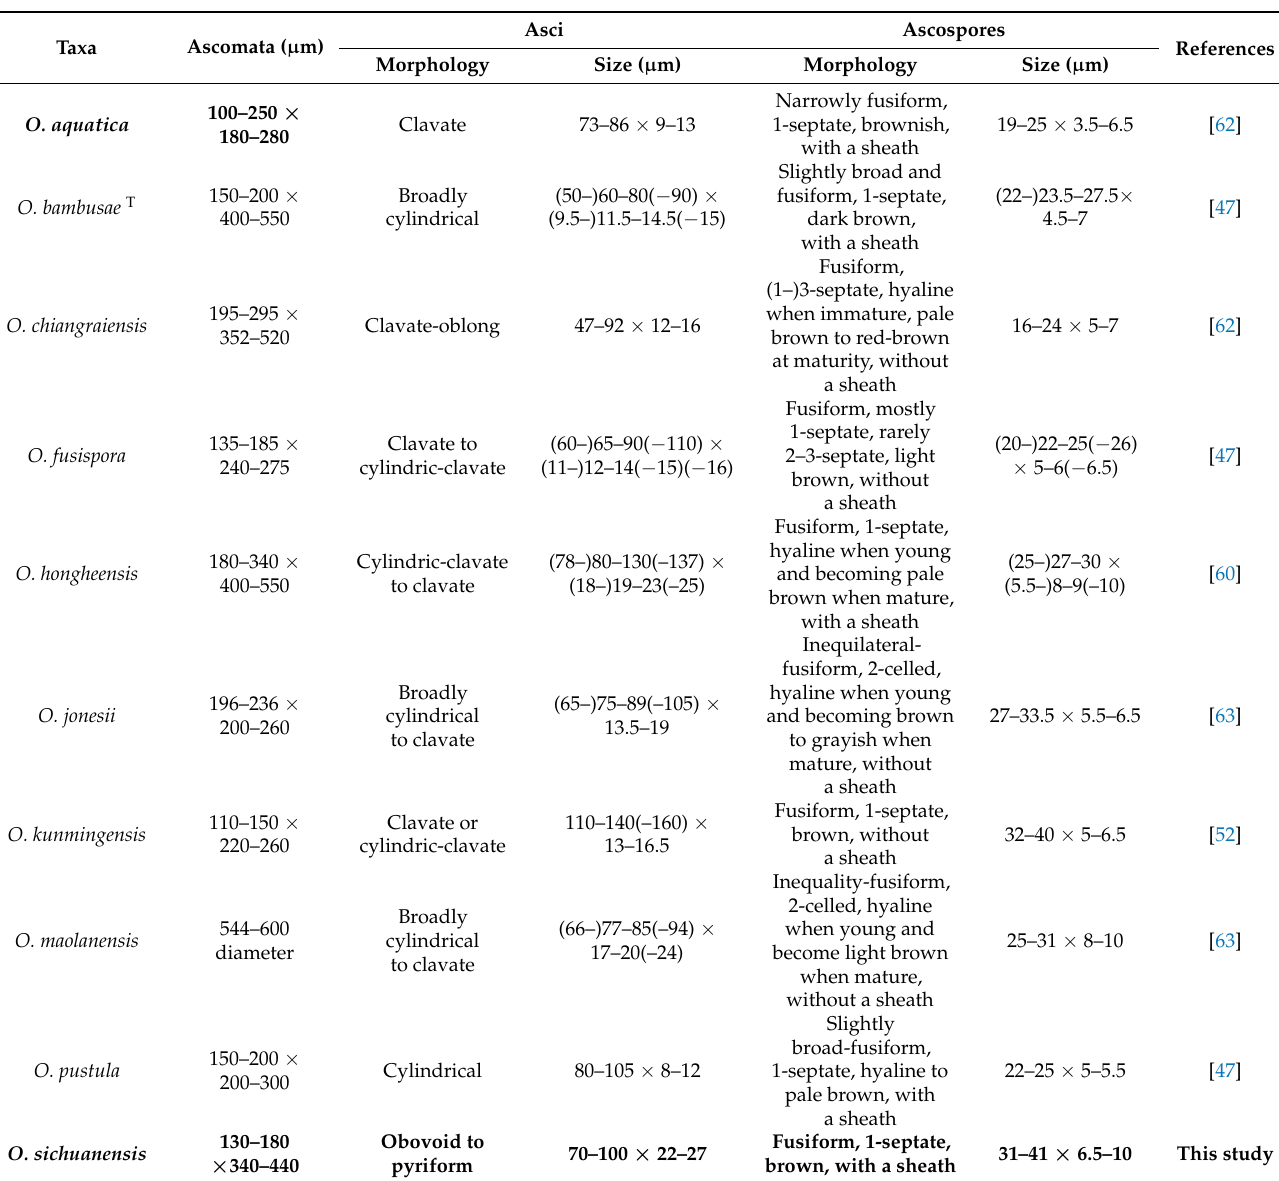
Table 4. Morphological comparative data of Occultibambusa